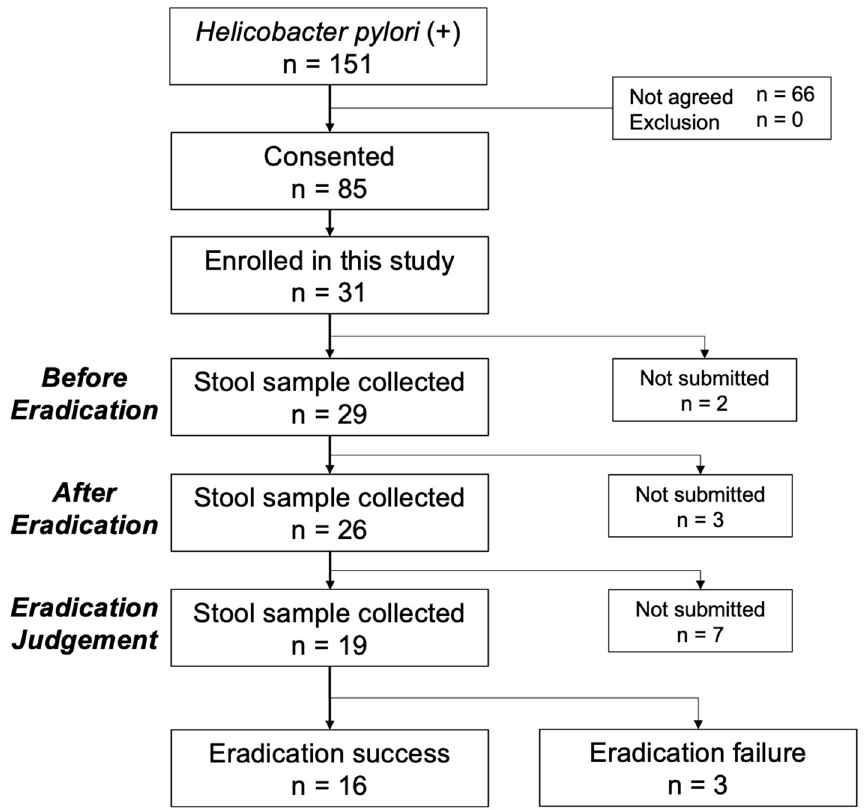
Figure 1. Flow chart of patient